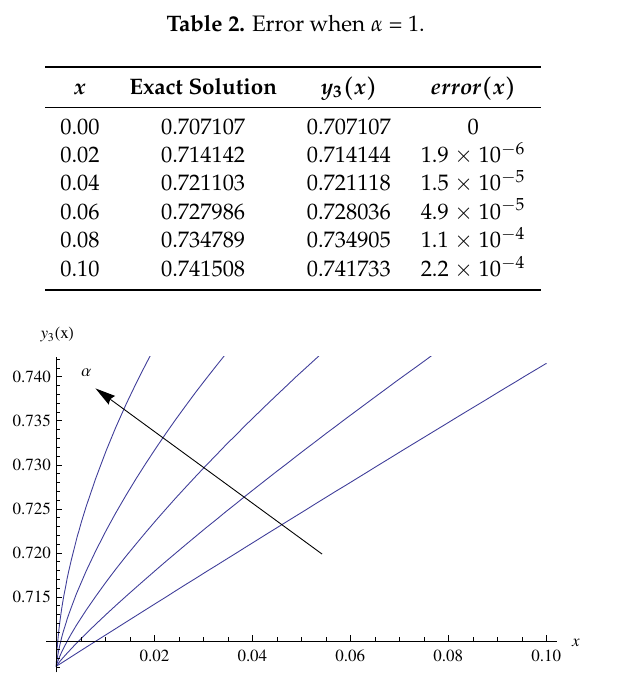
Figure 2. The approximate solution for α = 0.6, 0.7, 0.8, 0.9,